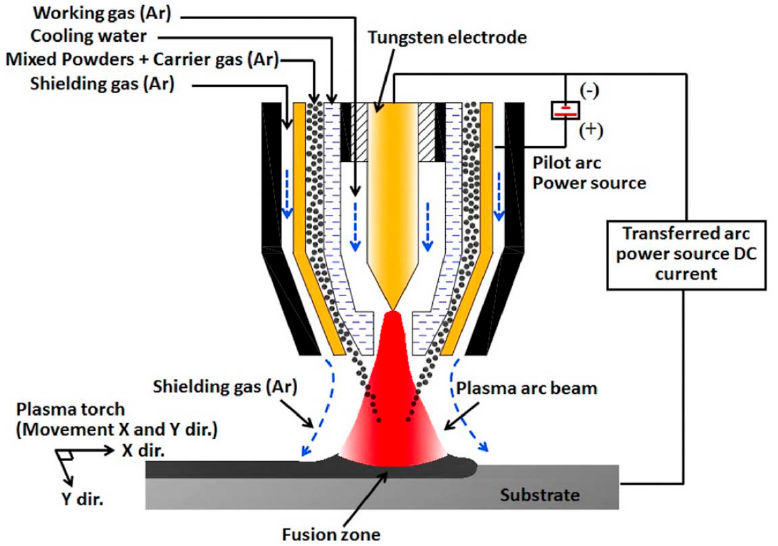
Figure 1. Scheme showing the plasma cladding systems for coaxial powder feeding case. Reprinted with permission from ref. [14]. Copyright 2021 Elsevier.